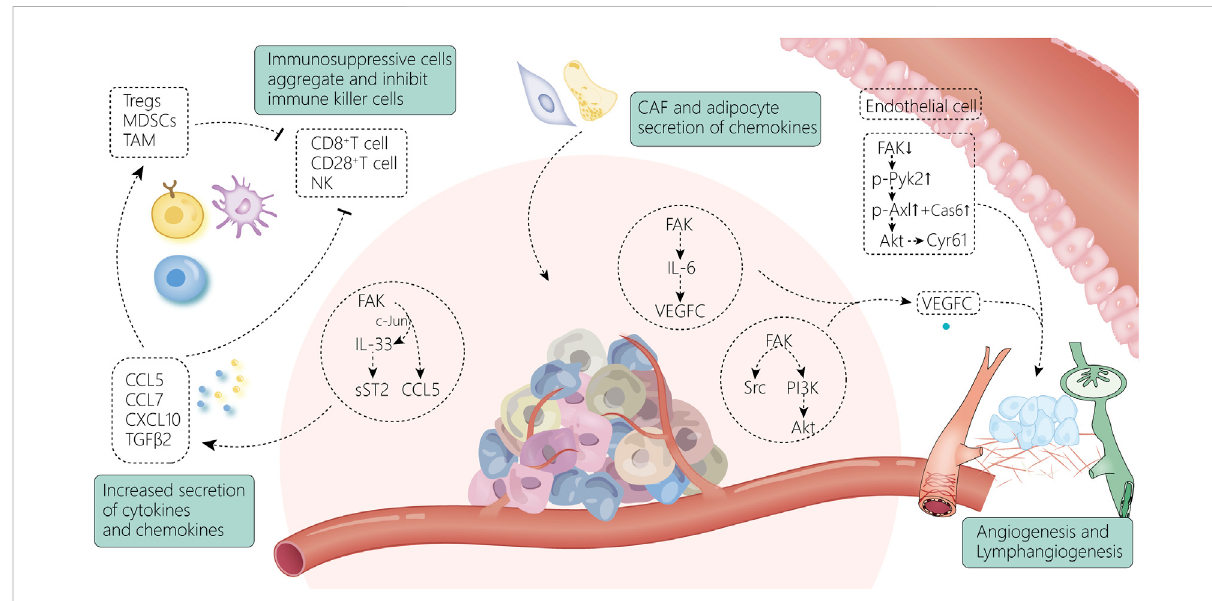
FIGURE 4 FAKandthetumormicroenvironmentareintricately linked.TheincreaseinchemokinessecretedbytumorcellsthroughFAK-relatedpathways induces the accumulation of immunosuppressive cells and suppresses immune killer cells, allowing tumor cells to gradually escape from the immune system (Huang et al., 2016a); meanwhile, FAK activates the VEGF-C-secreted signaling pathway within the tumor tissue, leading to enhanced vascular regeneration and lymphatic vessel regeneration around the tumor. Endothelial cells (Pedrosa et al., 2019), fi broblasts (Demircioglu et al., 2020), and adipocytes (Blücher et al., 2020) surrounding the tumor can also contribute to the shaping of the TME by activating FAK-related